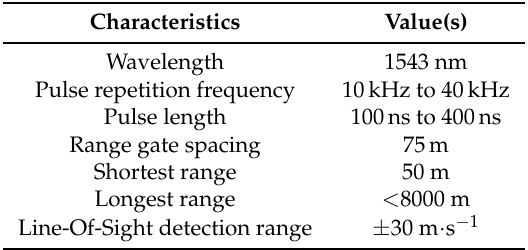
Table 2. Characteristics of the modified WindCube 200S used in the long-range WindScanner system during the Bjørnafjord measurement campaign.